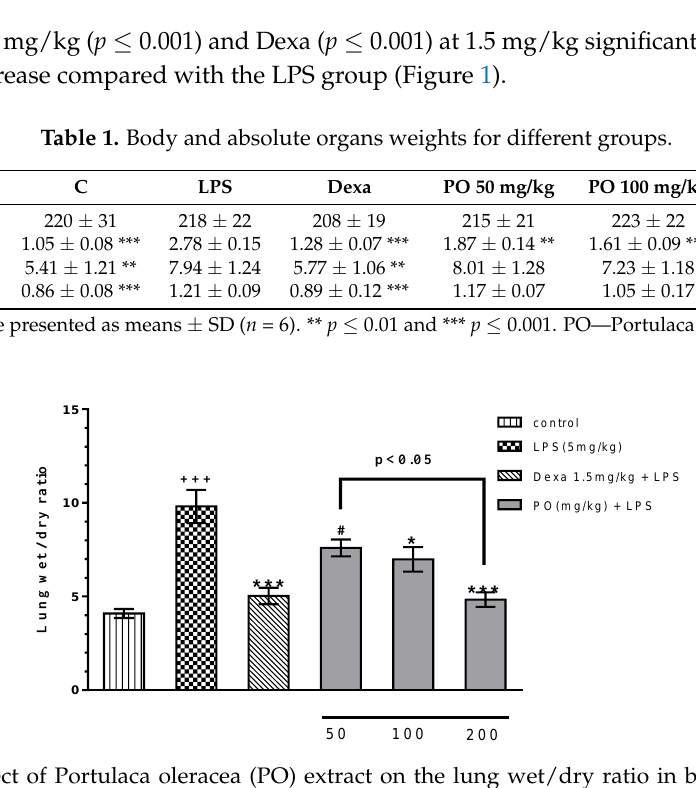
Table 1. Body and absolute organs weights for different groups.